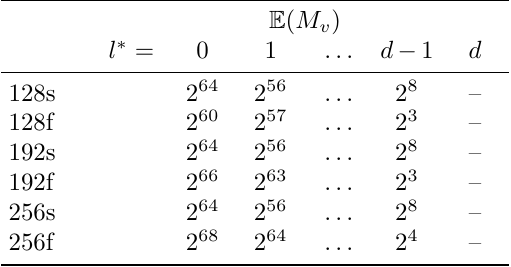
Table 5: Average numbers of valid signatures to collect the valid signature corresponding to a single faulty signature for all SPHINCS + parameters. E ( M v ) l ∗ =